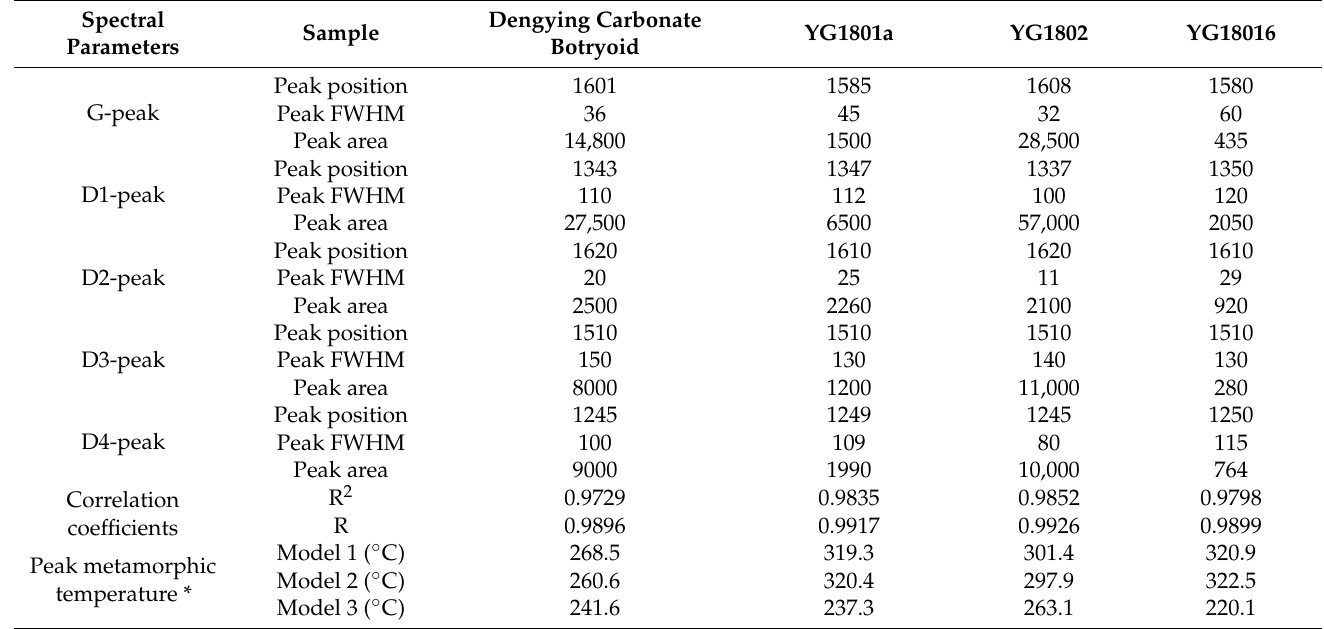
Table 2. Raman spectral parameters for the main peaks of organic matter in the four spectra analysed (Figure 7e), modelled to calculate peak metamorphic